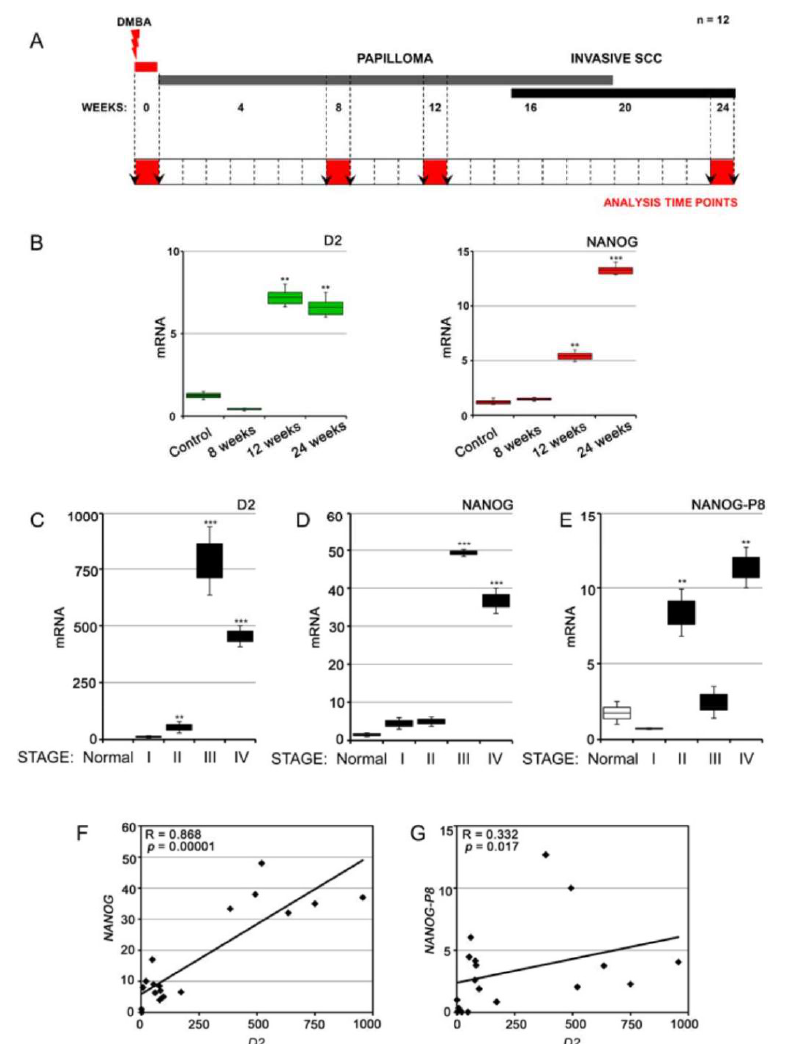
Figure 4. D2 and NANOG are co-expressed in the late phases of squamous cell carcinoma (SCC) tumor progression. ( A ) Schematic representation of the chemical cancerogenesis experiment for SCC tumor progression in mice. ( B ) Expression profile of D2 mRNA and NANOG mRNA during mouse SCC tumorigenesis. Data represent the mean of three independent experiments performed in triplicate. ( C – E ) The expression of D2, NANOG, and NANOG-P8 mRNA was measured in human SCC tumors at di ff erent pathologic stages in comparison with normal skin counterparts. All samples were run in triplicate and referred to normal skin set arbitrarily as 1. ( F , G ) Pearson’s correlation analysis was performed for the same data as in C–E. PCR analysis was performed in 20 di ff erent tissues for each grading. ** p < 0.01; *** p <